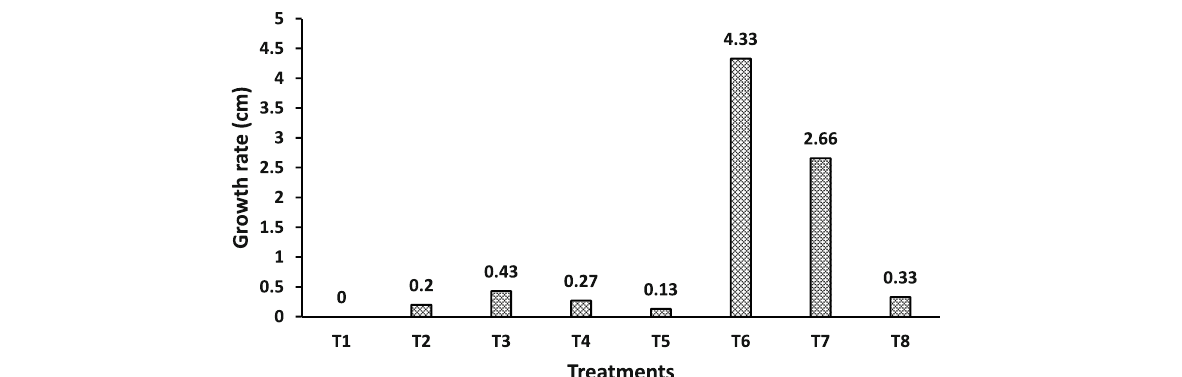
Fig. 4 The effect of different nano silver (ppm), algal extracts concentrations (%) and Bacillus% on growth rate of the Pectobacterium. T1 = Control, T2 = AgNps 50 ppm, T3 = AgNps 75 ppm, T4 = AgNps 100 ppm, T5 = Spirulina 50%, T6 = Spirulina 75%, T7 = Spirulina 100% and T8 = Bacillus subtilis%